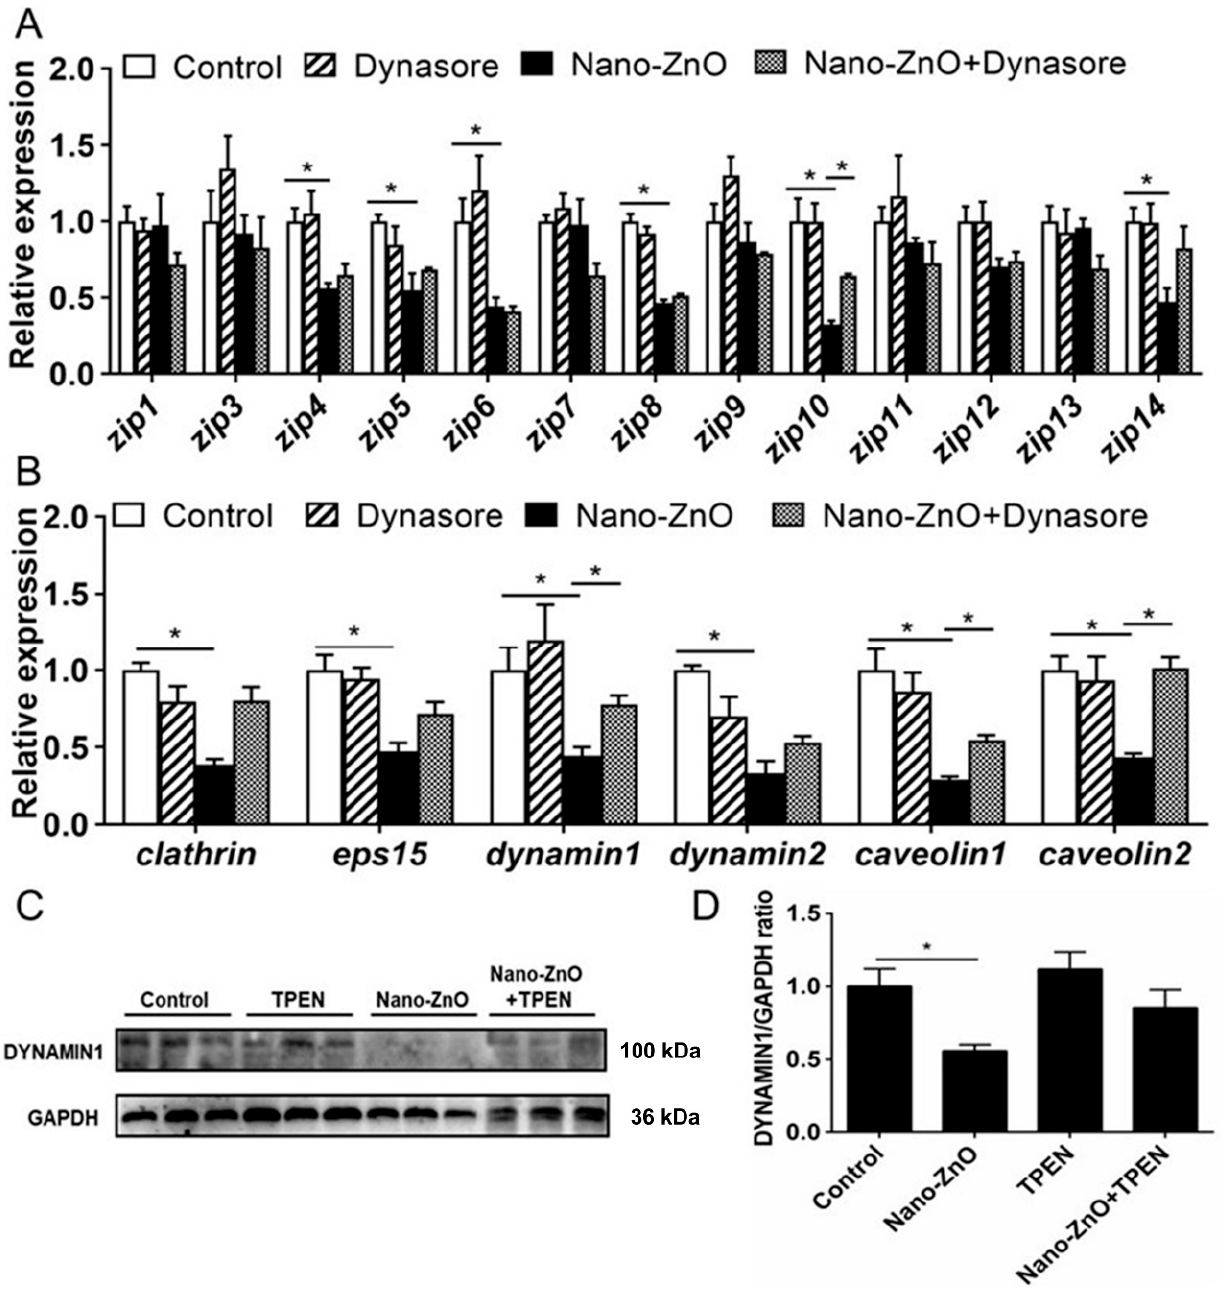
Figure 5. Effects of Nano-ZnO and Dynasore incubation on expression of genes and proteins involved in Zn absorption and transport of yellow catfish IECs. ( A ) The mRNA expression of Zn transport protein. ( B ) The mRNA expression of endocytosis genes. ( C ) Dynamin1 protein levels. ( D ) Quantification of Dynamin1 protein level. Different letters or asterisks (*) indicate the significant differences between the two groups ( p < 0.05). For each value, three biological replicates are undertaken.